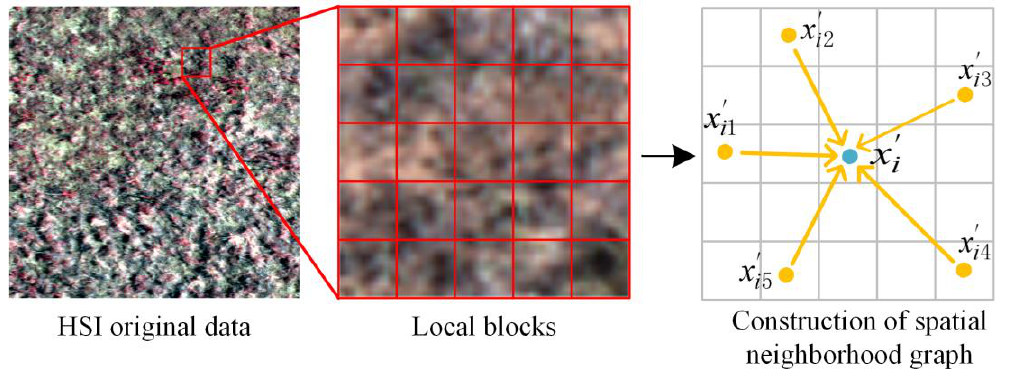
Figure 3. Construction of spatial neighborhood